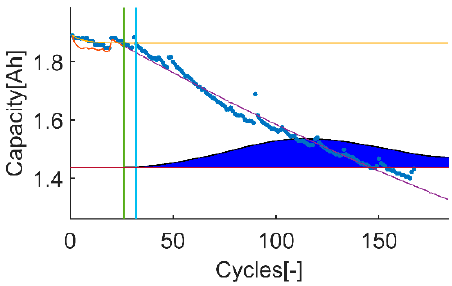
Figure 14. Time-instant figure of test 3 on t 17 .